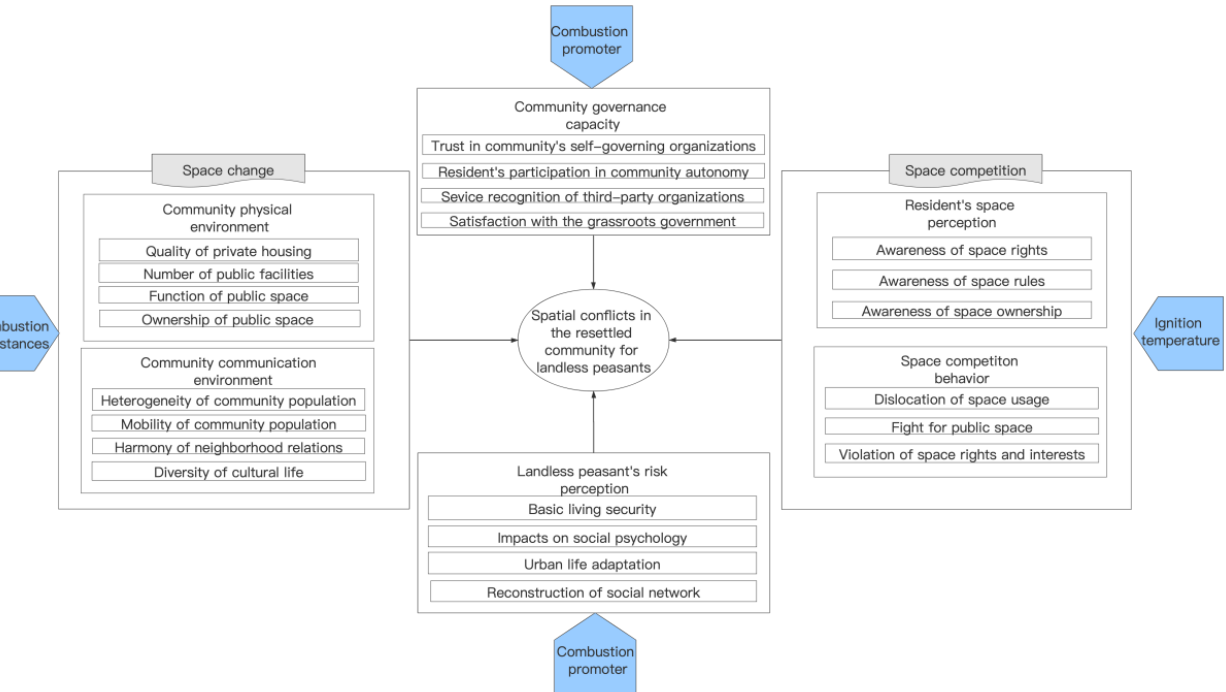
Figure 2. Conceptual model of spatial conflict in a demolition and resettlement community.